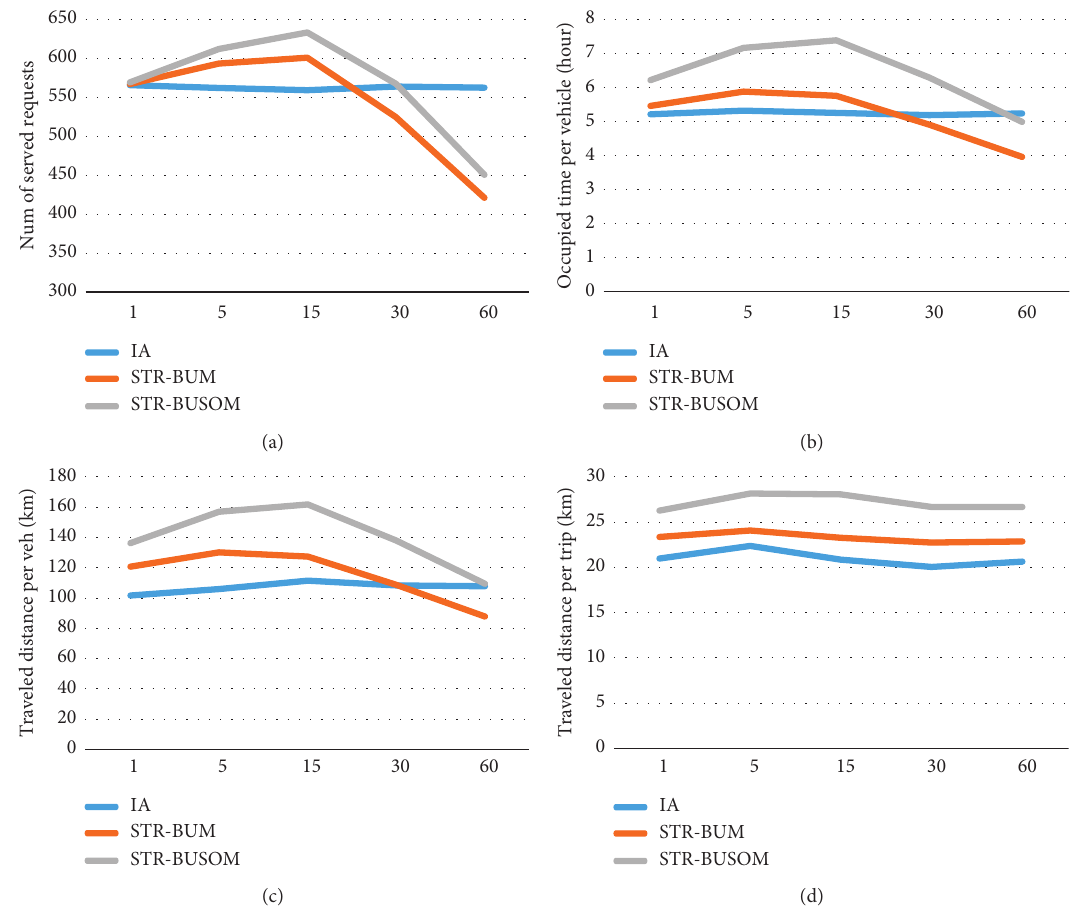
Figure 11: System performance for different values of τ . (a) Number of served requests. (b) Average occupied time per vehicle. (c) Average traveled distance per vehicle. (d) Average traveled distance per trip.